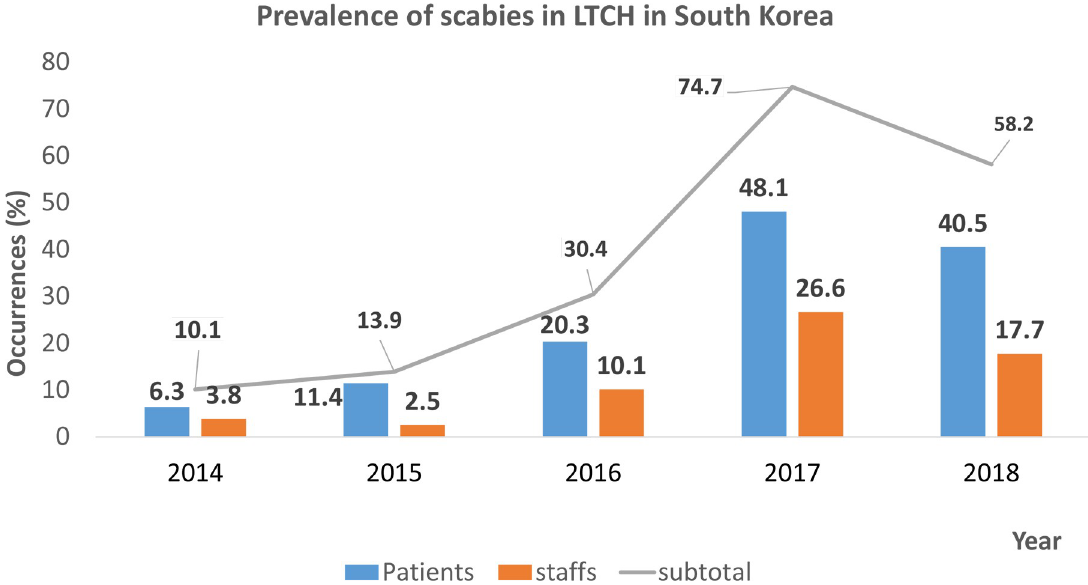
Fig 2. Prevalence of scabies in long-term care hospitals (LTCHs) in South Korea. Among the 110 LTCHs, cases of scabies were reported in 79 LTCHs. The prevalence of scabies in each year was calculated based on the number of hospitals that reported scabies cases (n =